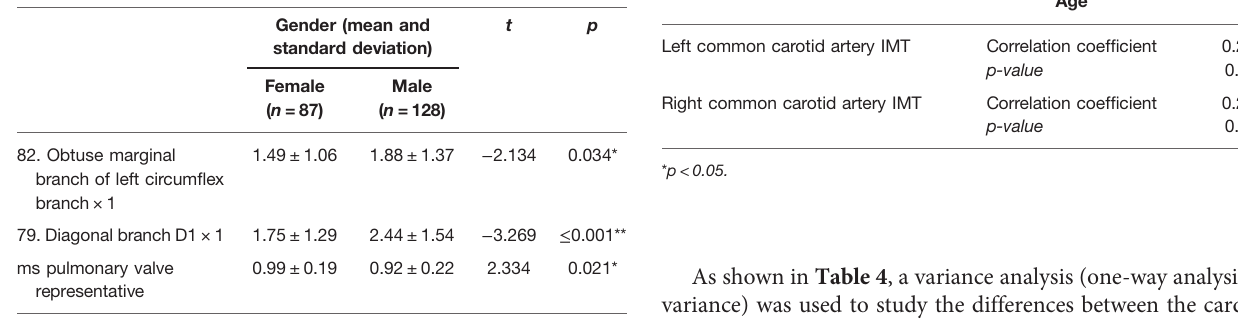
TABLE 1 | t -Test analysis of sex and obtuse marginal branch of the left circum fl ex branch×1, diagonal branch D1×1, and ms pulmonary valve representative.